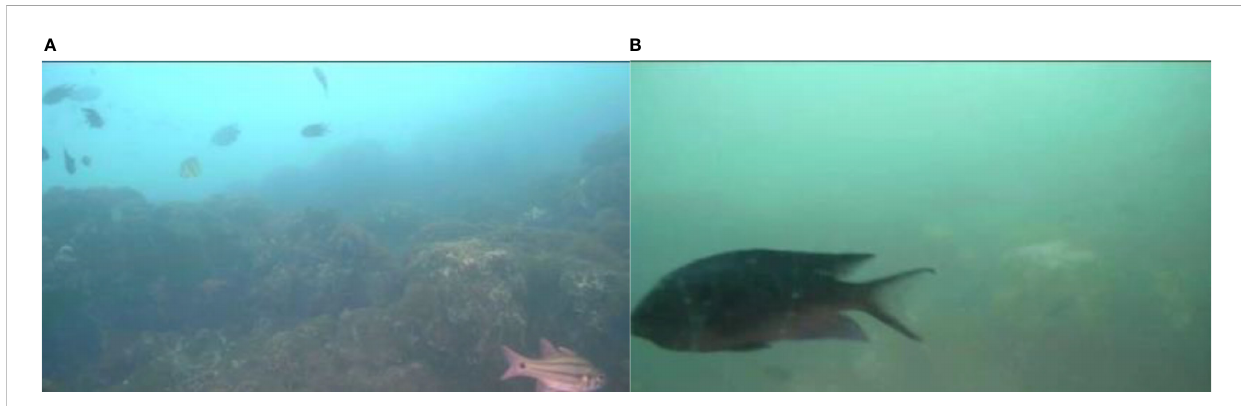
FIGURE 1 Challenges and problems in natural marine ranch environments: (A) a bluishimage with color distortion; (B) a low contrast and texture blurred